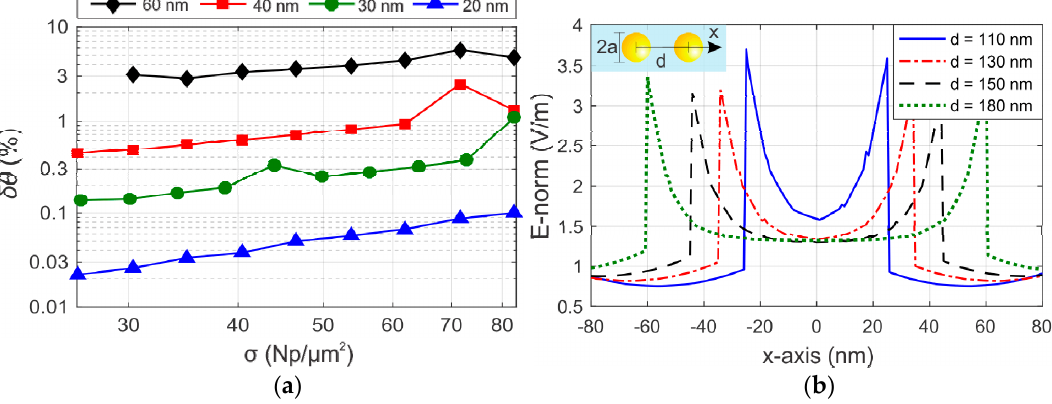
Figure 8. ( a ) Relative deviation δθ between the resonance angles θ FEM and θ MG relative to an Au/SiO 2 monomodal sensing platform with a dielectric thickness of 50 nm. The data are represented for AuNPs diameters of 20, 30, 40 and 60 nm, and surface densities σ between 26 and 83 Np/µm 2 . ( b ) E z field between two adjacent AuNPs with the diameter of 60 nm embedded in water. The centers of the AuNPs are separated by the distance d , as highlighted in the inset.